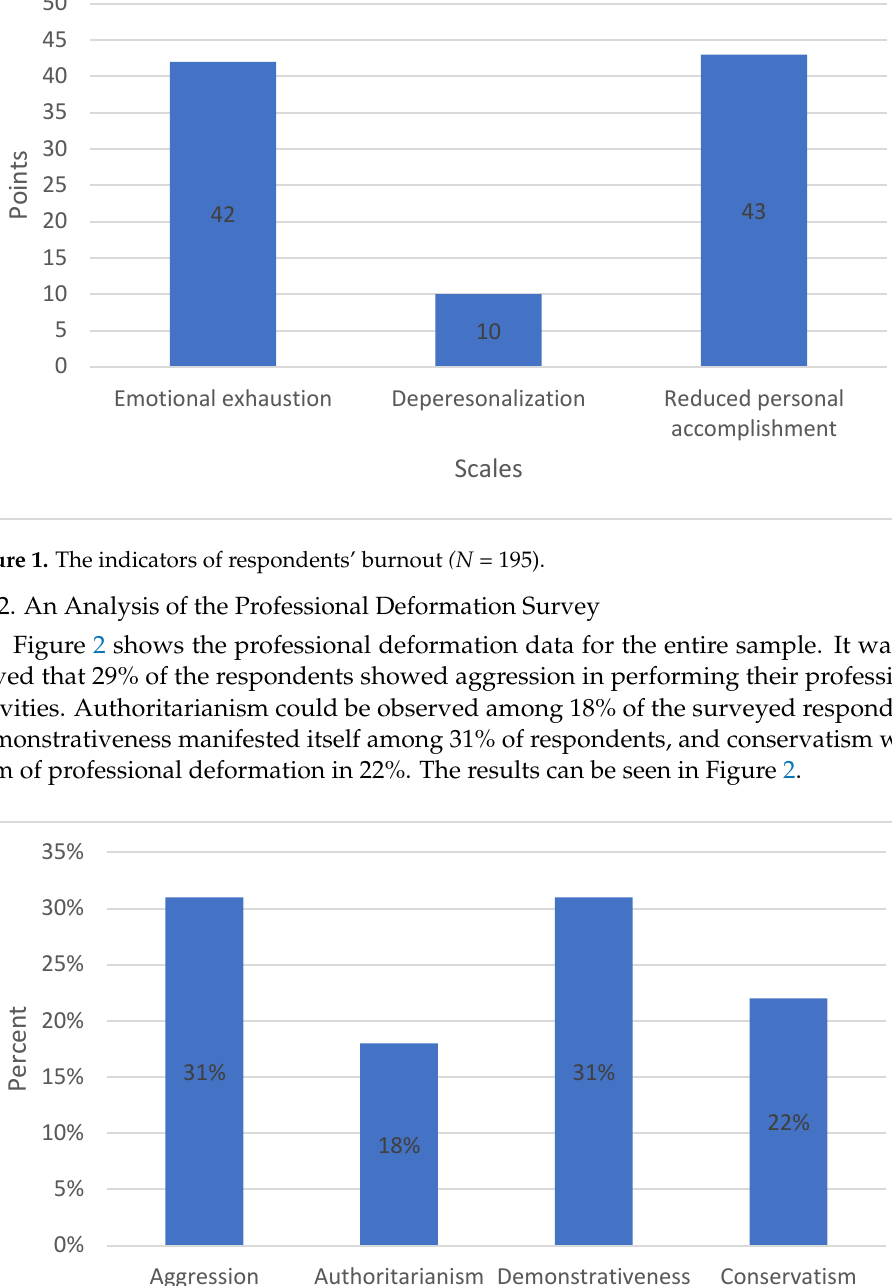
Figure 2. The results of professional deformation.